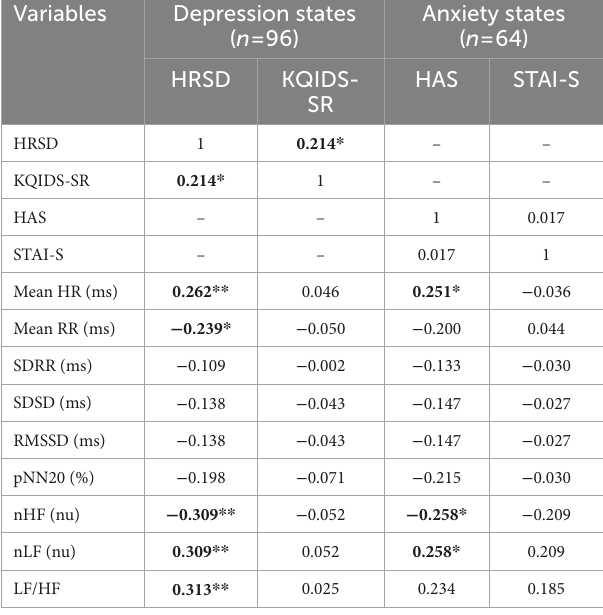
TABLE 2 Correlations matrix between HRV indices and clinical measures (clinician-rated and self-rated report).